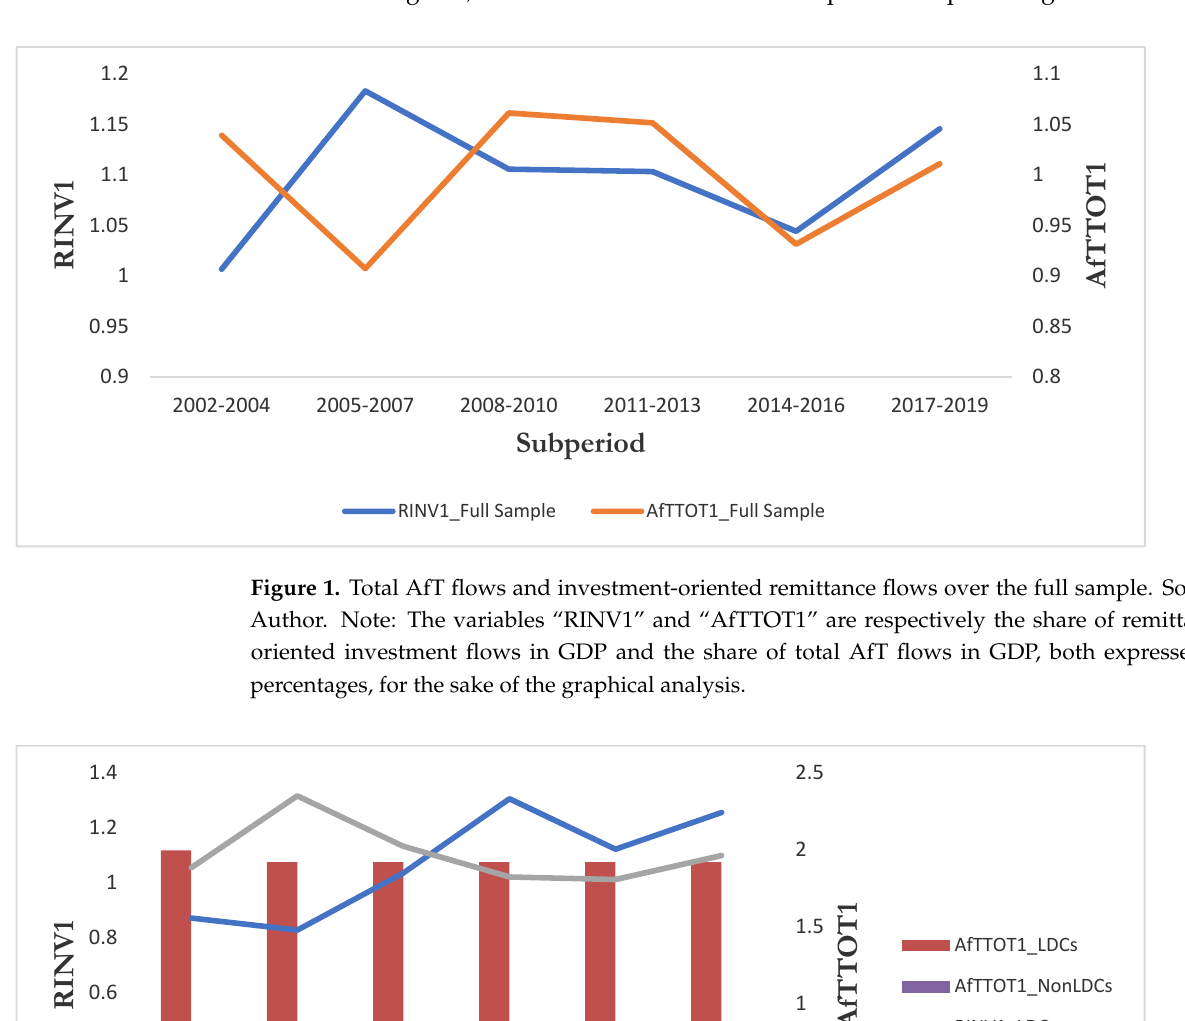
Figure 3. Correlation patterns between AfT flows and investment-oriented remittance flows over the full sample. Source: Author. Note: The variable “RINV” is the natural logarithm of the share of remittance-oriented investment in GDP (not expressed in percentage). AfT variables are the natural logarithm of the share of AfT flows in GDP (not in percentage), where AfT is either total AfT flows or each of its categories.